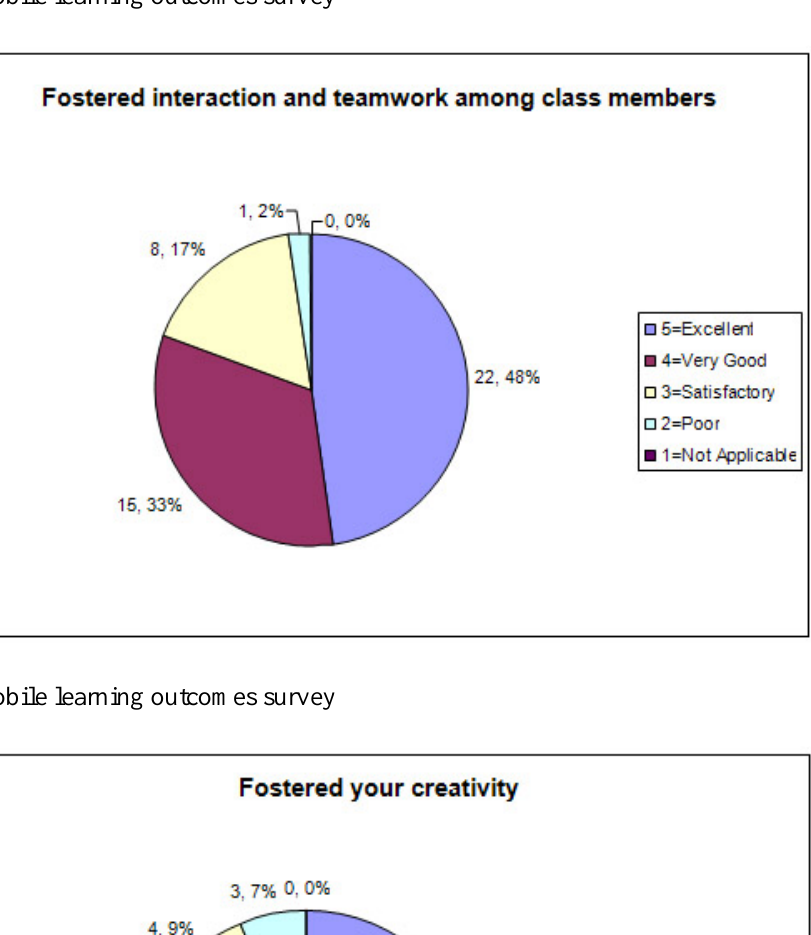
Figure 7. Mobile learning outcomes survey